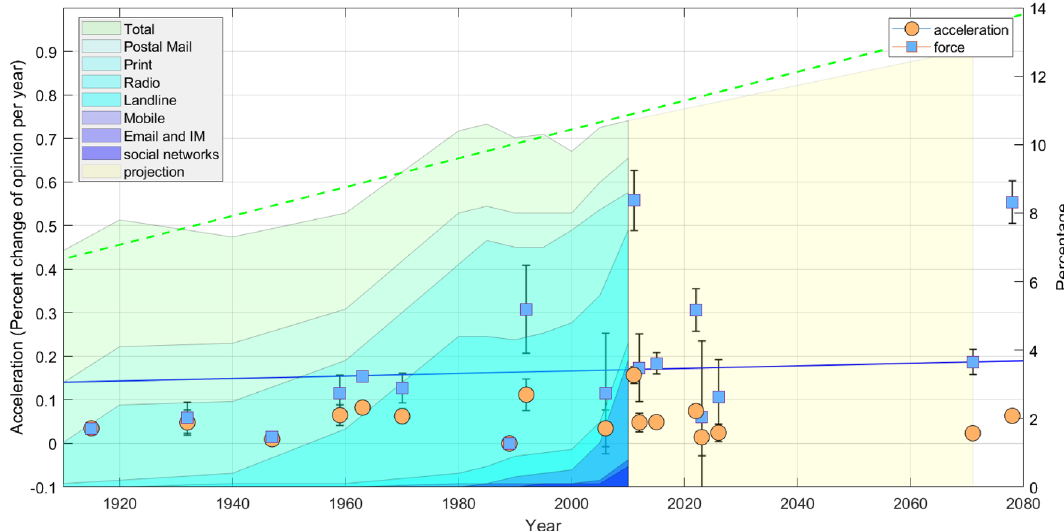
Figure 5. Acceleration and force versus year. Details of the technologies, fits, and data are given in the